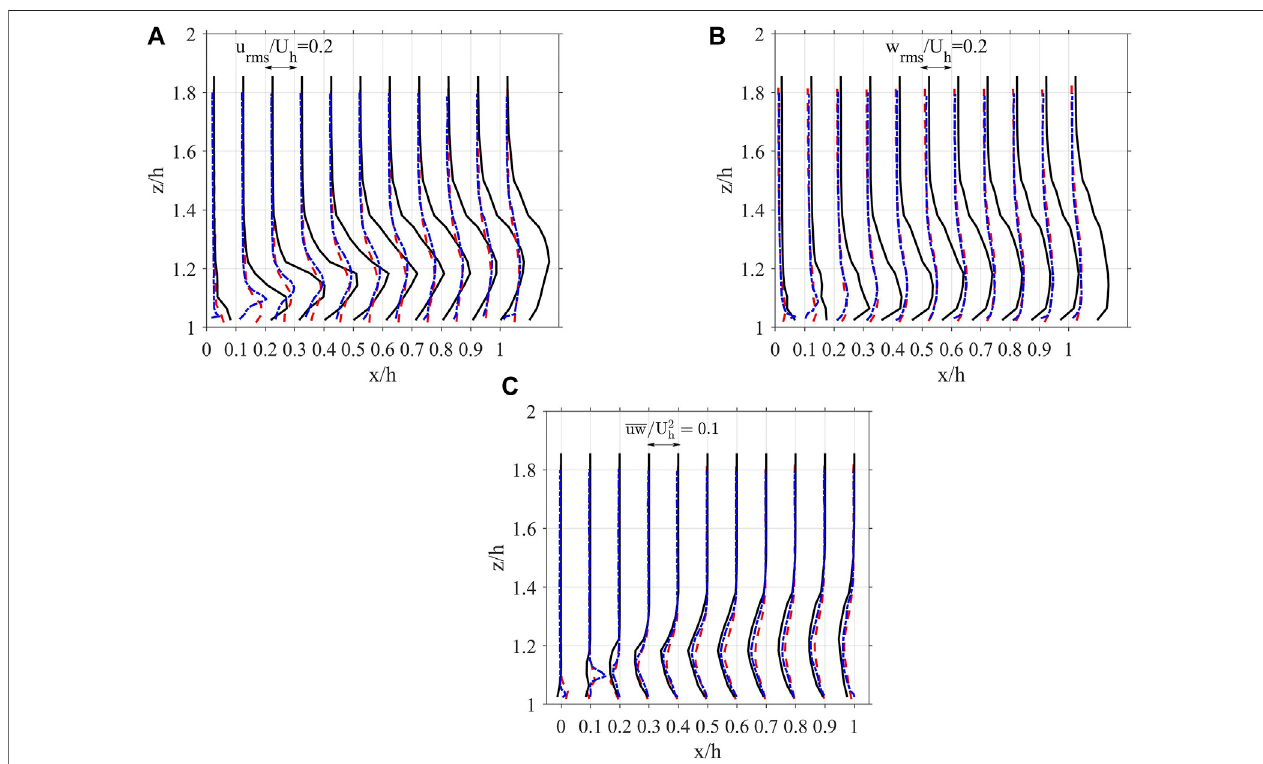
FIGURE6| Pro fi lesof (A) thestreamwisevelocityrms; (B) theverticalvelocityrms;and (C) Reynoldsshearstress uw in fl owmodelvalidationstudy;theexperiment (blue dashed-dotted line) and simulation (red dashed line) of Lim et al. (2009), and the present simulation (solid line).